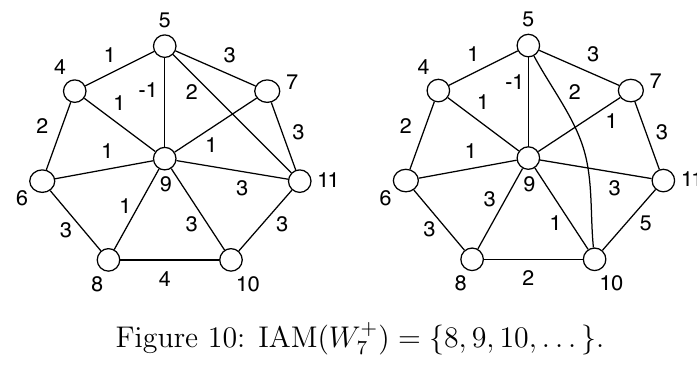
Figure 10: IAM( W +